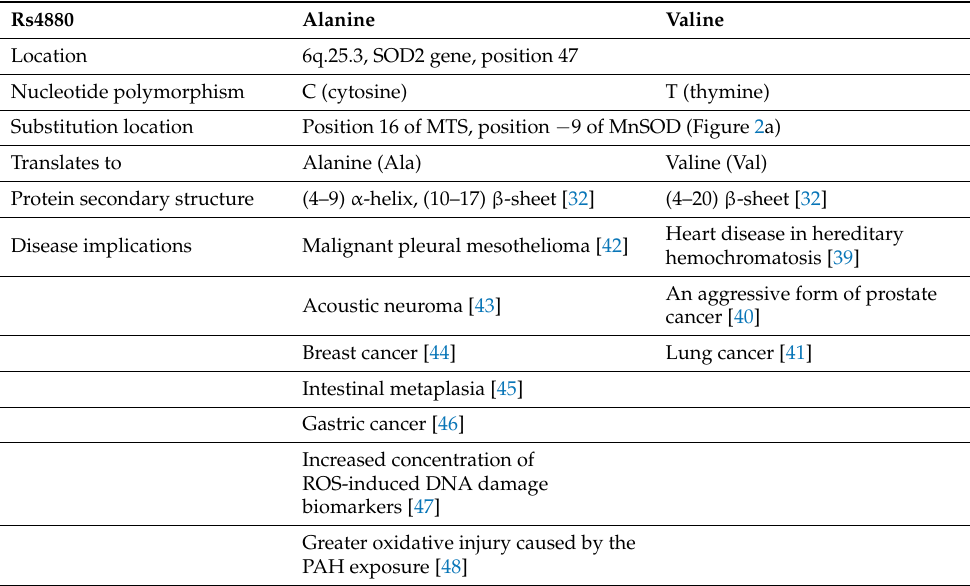
Table 1. Comparison of the alanine to valine substitution resulting from SNP rs4880.